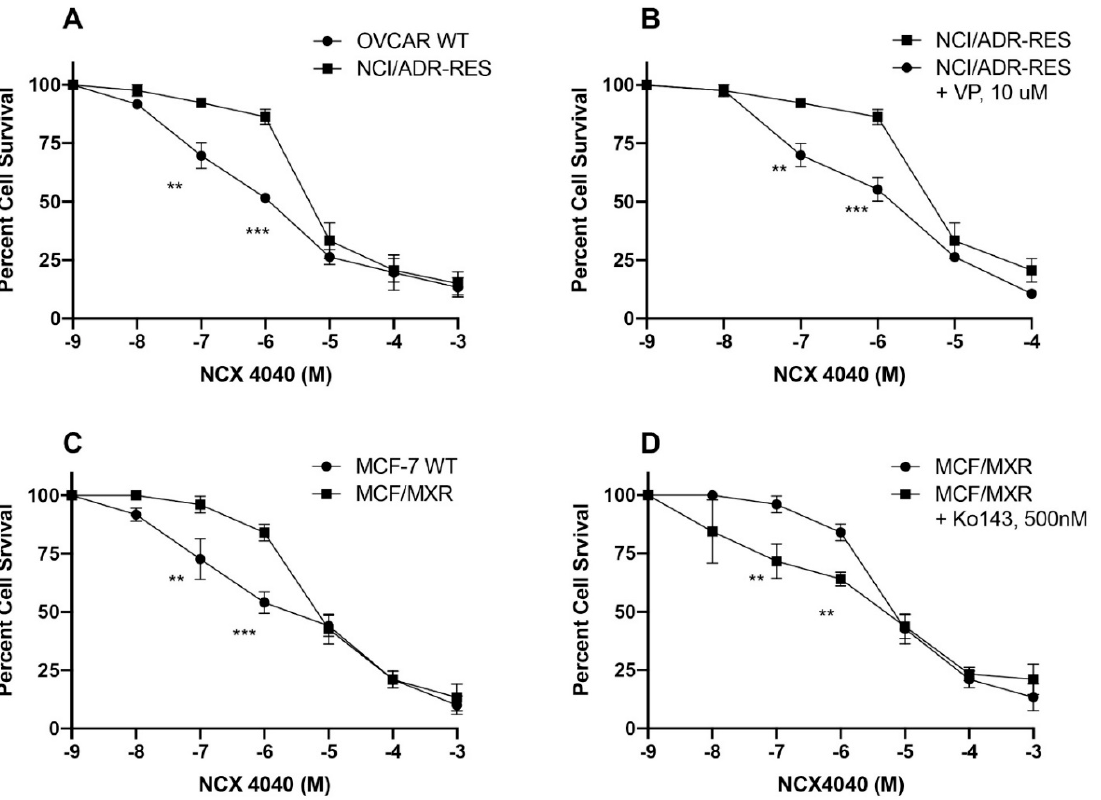
Figure 5. Cytotoxicity of NCX4040 in ( A ) WT OVCAR-8 and NCI-RES/ADR cells, ( C ) WT MCF-7 and MXR cells. Effects of verapamil (10 µM, ( B )) and Ko143 (0.5 µM, ( D )) on cytotoxicity of NCX4040 in NCI/ADR-RES and in MXR cells, respectively. ** and *** p values, <0.005 and <0.001, respectively compared to concentration-matched samples.